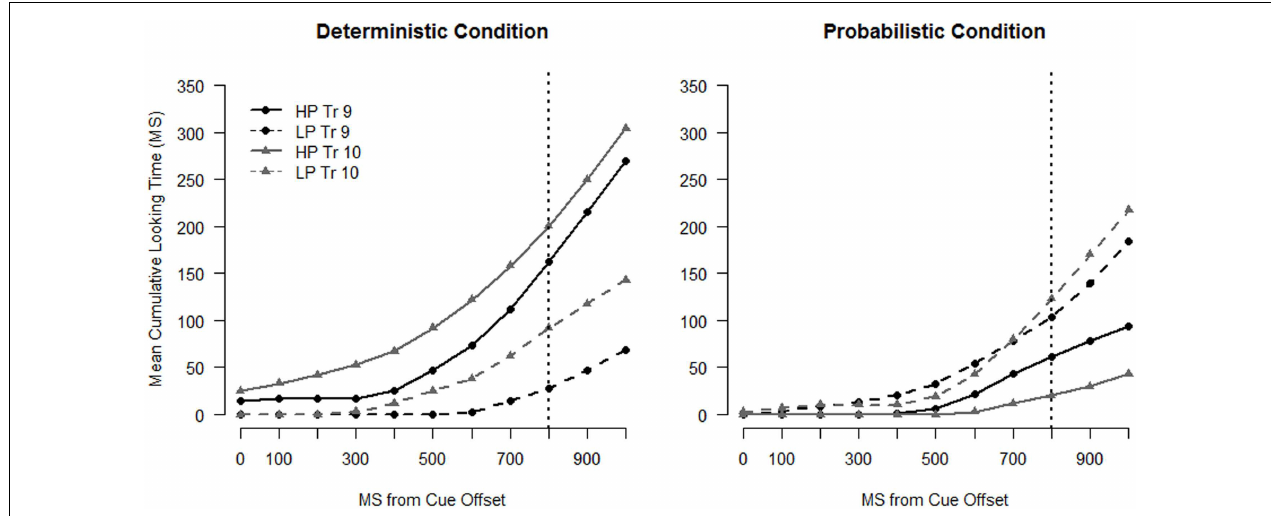
FIGURE 4 | Cumulative time spent looking to the high probability (HP) and low-probability (LP) location for infants in the Deterministic condition (left panel) and infants in the Probabilistic condition (right panel) forTrial 9 andTrial 10. The dotted vertical line indicates target